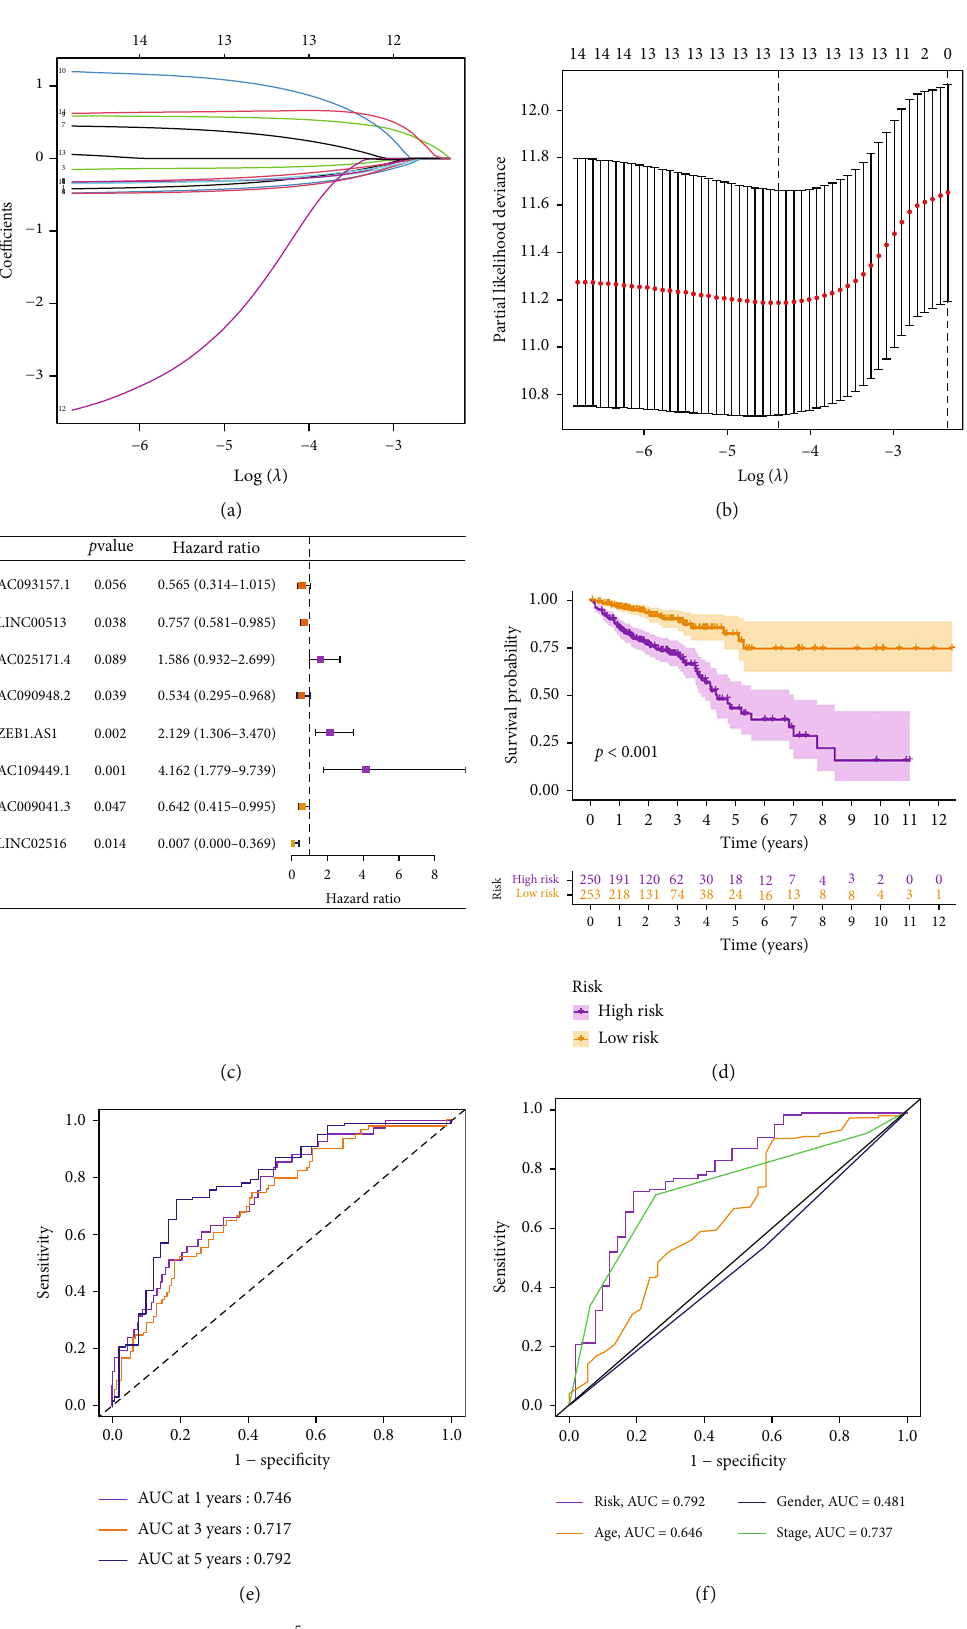
Figure 2: Construction of a risk signature for m 5 CRlncRNAs. (a, b) The LASSO regression algorithm to screen candidate m 5 CRlncRNAs. (c) Multivariate Cox regression analysis to develop a risk model. (d) Kaplan-Meier curves. (e) The 1-, 3-, and 5-year ROC curves of the entire set. (f) The 5-year ROC curves of the model and clinical